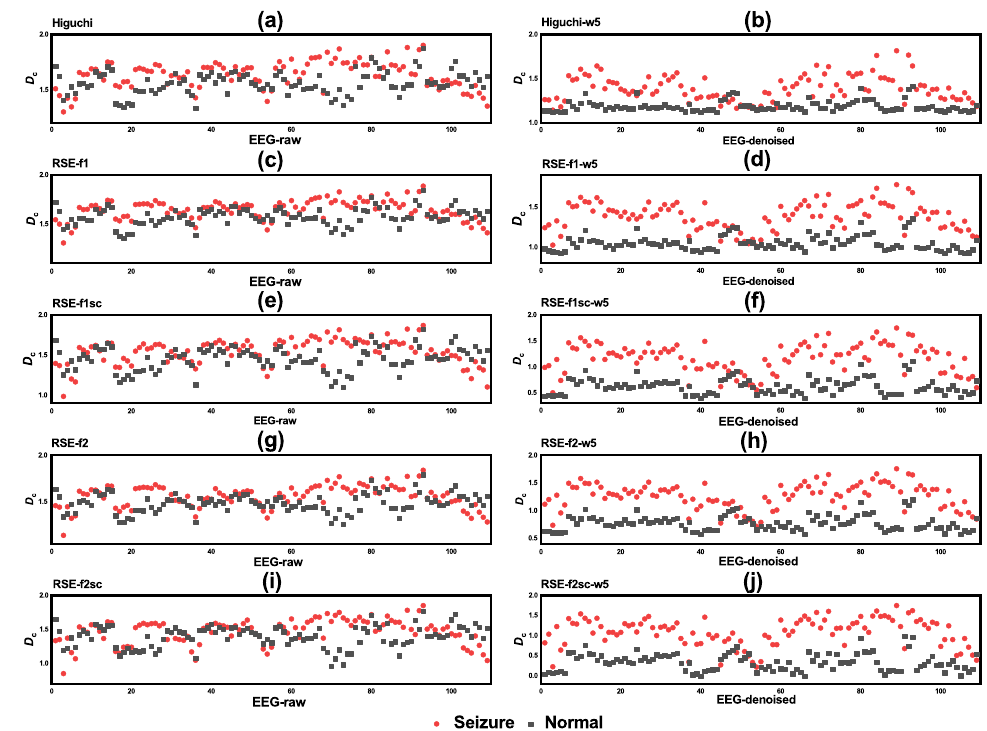
Figure 4. D c mean values by using various algorithms: ( a , c , e , g , i ) raw EEG signals; ( b , d , f , h , j ) denoised EEG signals. Red and black symbols represented seizure and normal statuses,